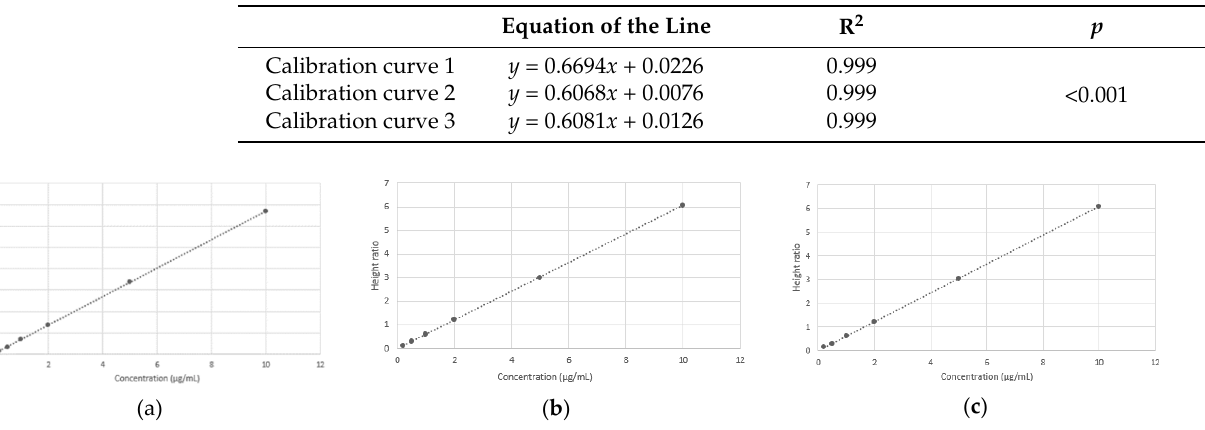
Figure 3. Representation of the three calibration curves obtained. ( a ) curve 1; ( b ) curve 2; ( c ) curve 3.